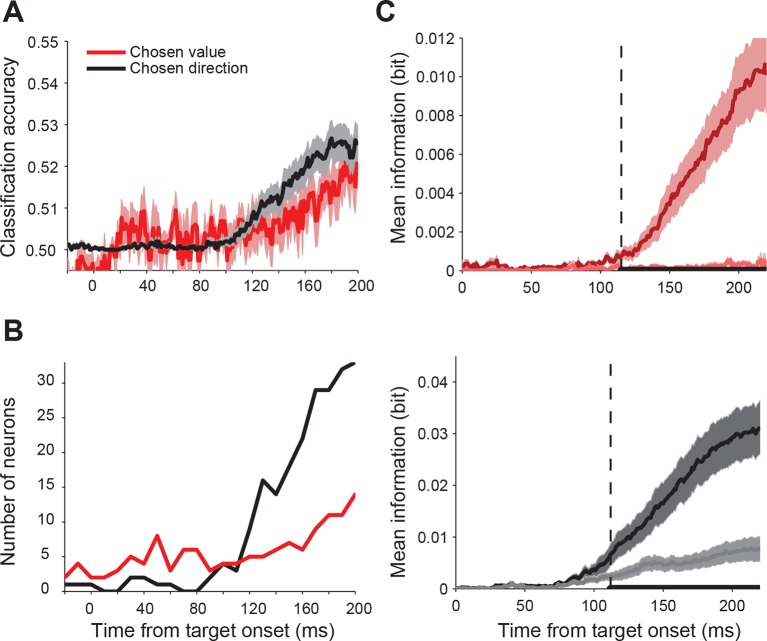
Time course of value and saccade direction representation in SEF aligned on target onset.In our gamble task, the monkey was free to indicate his choice as soon as he was ready. Because of this design feature, the saccade onset is likely to be closer aligned with the conclusion of the decision process than target onset. The fact that reaction time reflected chosen value and non-chosen value difference (i.e. choice difficulty), as indicated in Figure 2, further confirms this idea. In the main text, we analyzed therefore the neural activity aligned on movement onset, because it likely reflects the dynamic of the decision process more accurately. The analysis of the neural activity aligned on target onset further confirms this conclusion. (A) Average significant classification accuracy for chosen value (red) and chosen direction (black) across 128 neurons. The decoding analysis shows that the SEF activity predicts chosen value early in the trial, but only weakly and over a widely spread out time period. Only late in the trial did the prediction accuracy of the chosen value increase. At this stage, the prediction of the saccade direction had already begun to increase. (B) Number of neurons showing significant classification accuracy for chosen value (red) and chosen direction (black). The time course of the number of neurons with significant predictions shows a similar pattern, which likely reflects the variable relationship between target onset and decision making. (C) Average mutual information between SEF activity and chosen and non-chosen value (top panel; dark and light red) and saccade direction (bottom panel; dark and light grey). Note that the onset of significant levels of chosen value and direction signals in the population are both late relative to target onset and nearly simultaneous. The time period when the amount of information about chosen and non-chosen direction/value was significantly different are indicated by the thick black line at the bottom of the plots. The onset of a significant difference is indicated by the vertical dashed line. The shaded areas represent SEM. Compare this figure with Figure 3 in the main text. SEF, supplementary eye field.